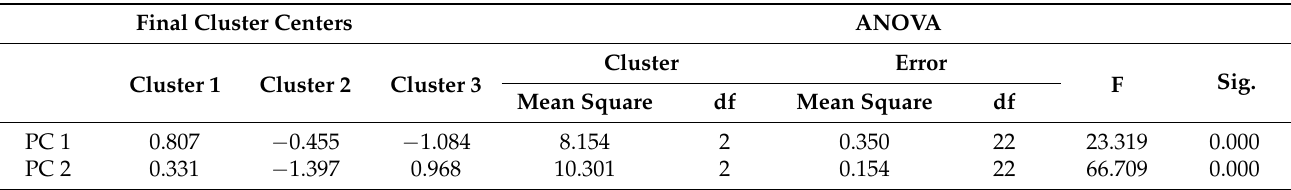
Figure 4. EU clusters based on PCA and CA. Table 6. The results of the cluster analysis: final cluster centers and